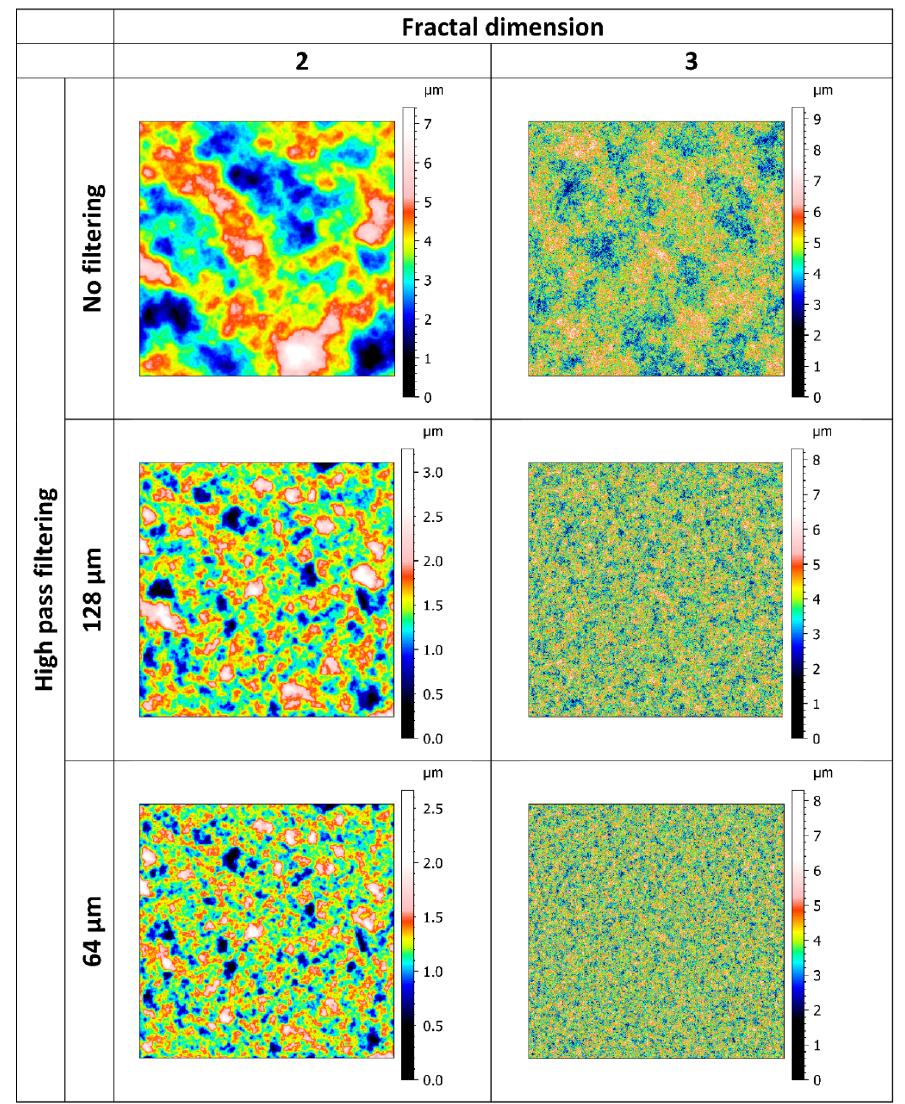
Figure 1. Examples of Weierstrass surfaces (1024 × 1024 µm²) with S q equal to 0.5 µm, fractal dimensions equal to two or three, and no filtering or high-pass filtering with different wavelengths.